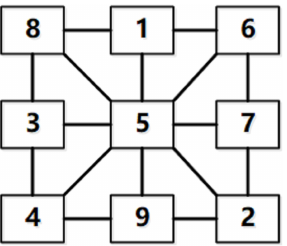
Figure 11. A visual reference topological structure diagram of the 3 × 3 magic square.